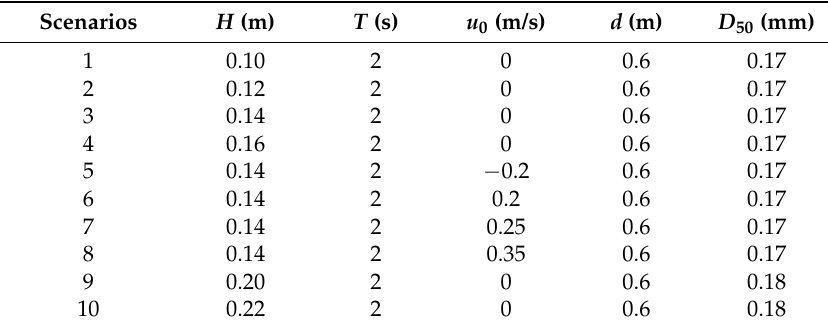
Table 1. Experimental